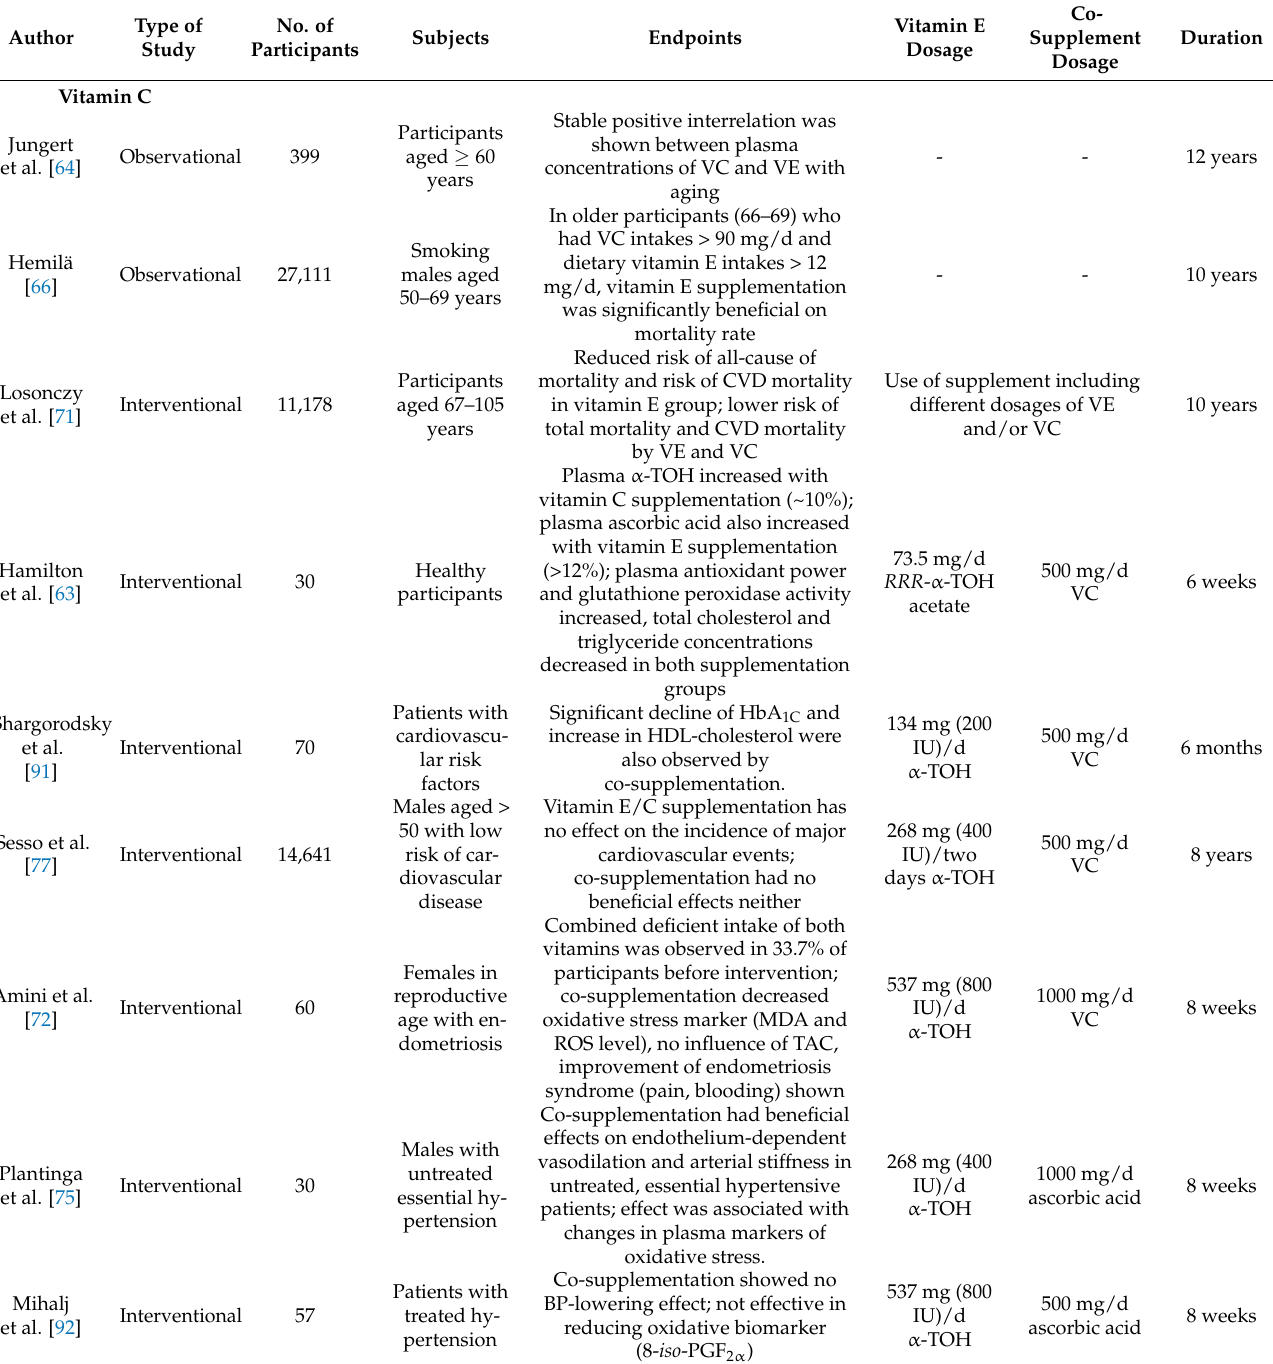
Table 1. Co-supplementation of vitamin E and other micronutrients and their effect on metabolic